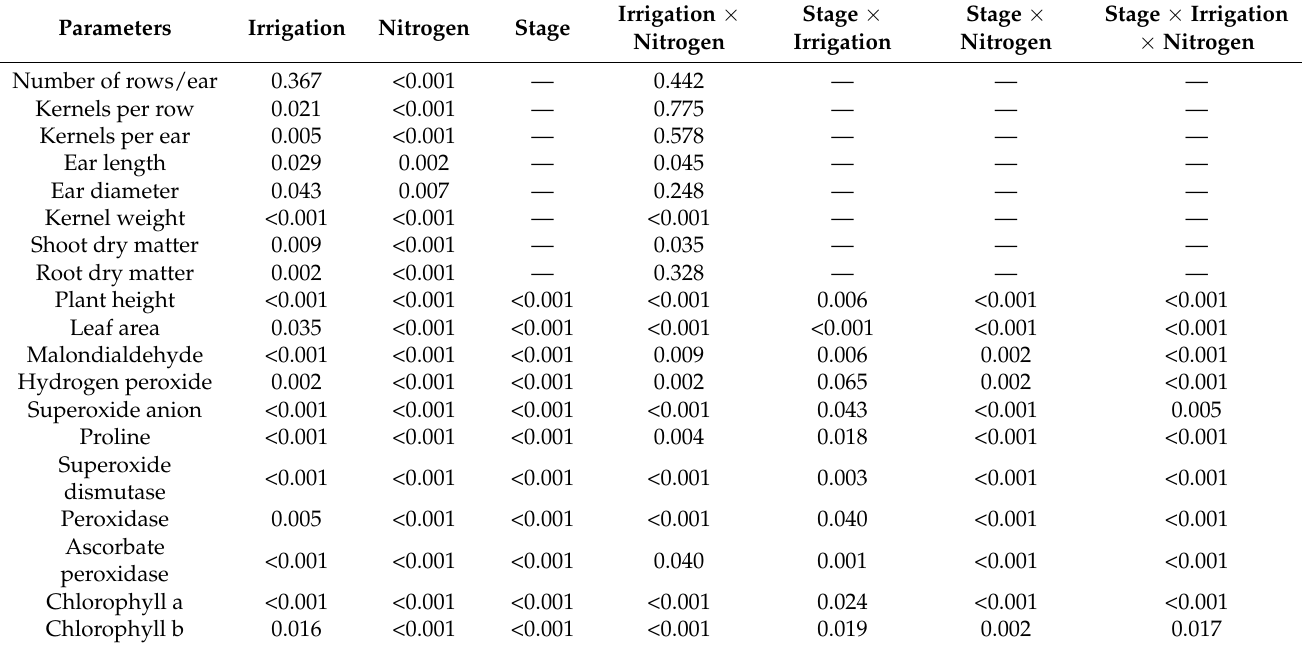
Table 2. Probability values ( p values) of main and interaction effects for irrigation, nitrogen treatment and stage (V9, R1, R3, R6) for various maize